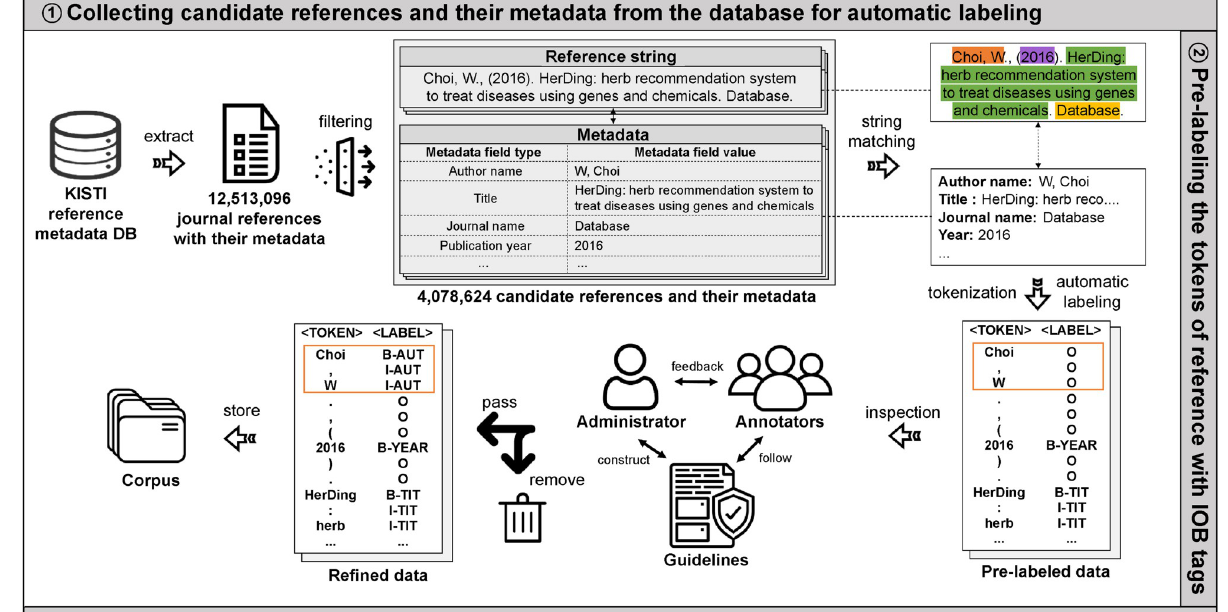
Fig 3. Workflow of corpus construction. The corpus was constructed as detailed in the following steps: (i) we first collected candidate references and their metadata from the KISTI database to automatically label the references; (ii) we then tokenized all the reference strings and pre-labeled the tokens of each reference string with IOB tags using a string matching approach based on the corresponding metadata field values; (iii) we precisely inspected whether the tokens of each reference string were correctly labeled based on the annotation guidelines.